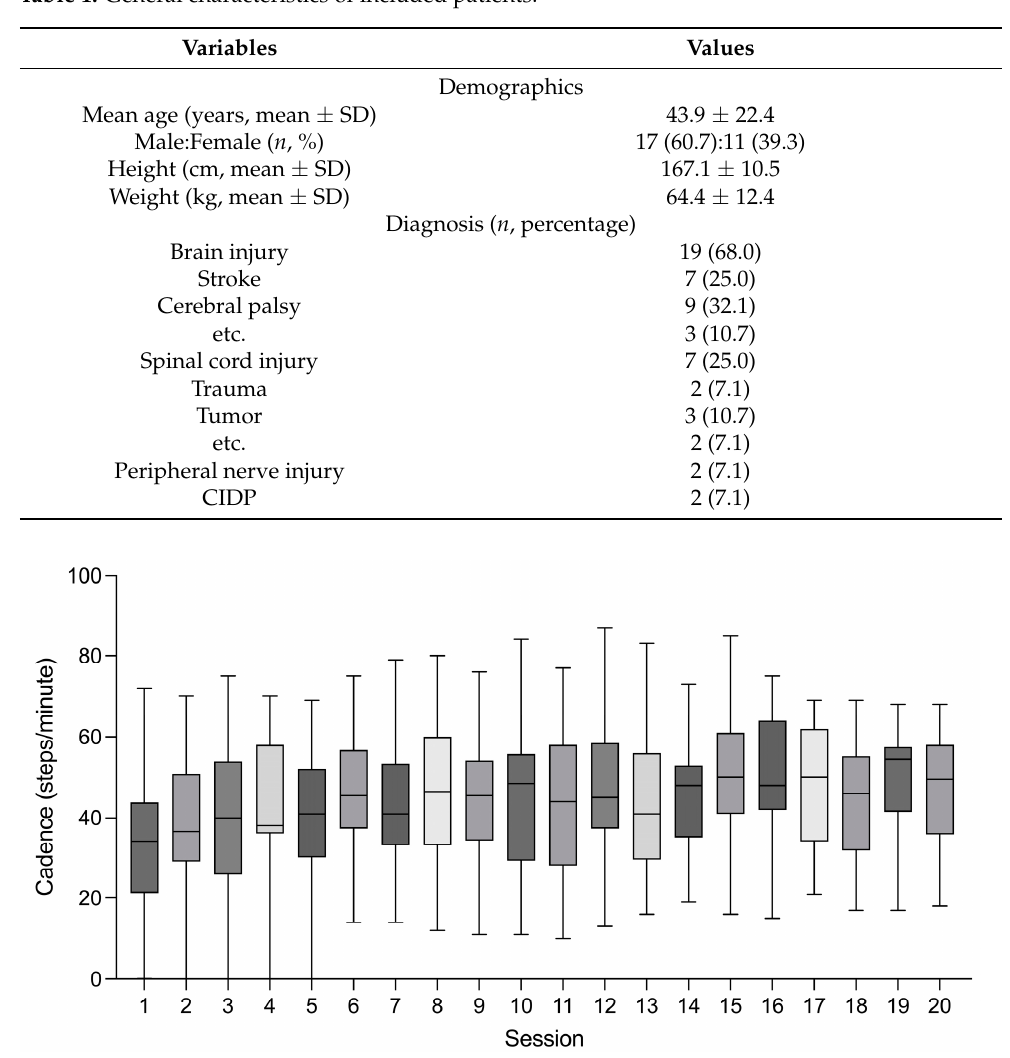
Table 1. General characteristics of included patients.